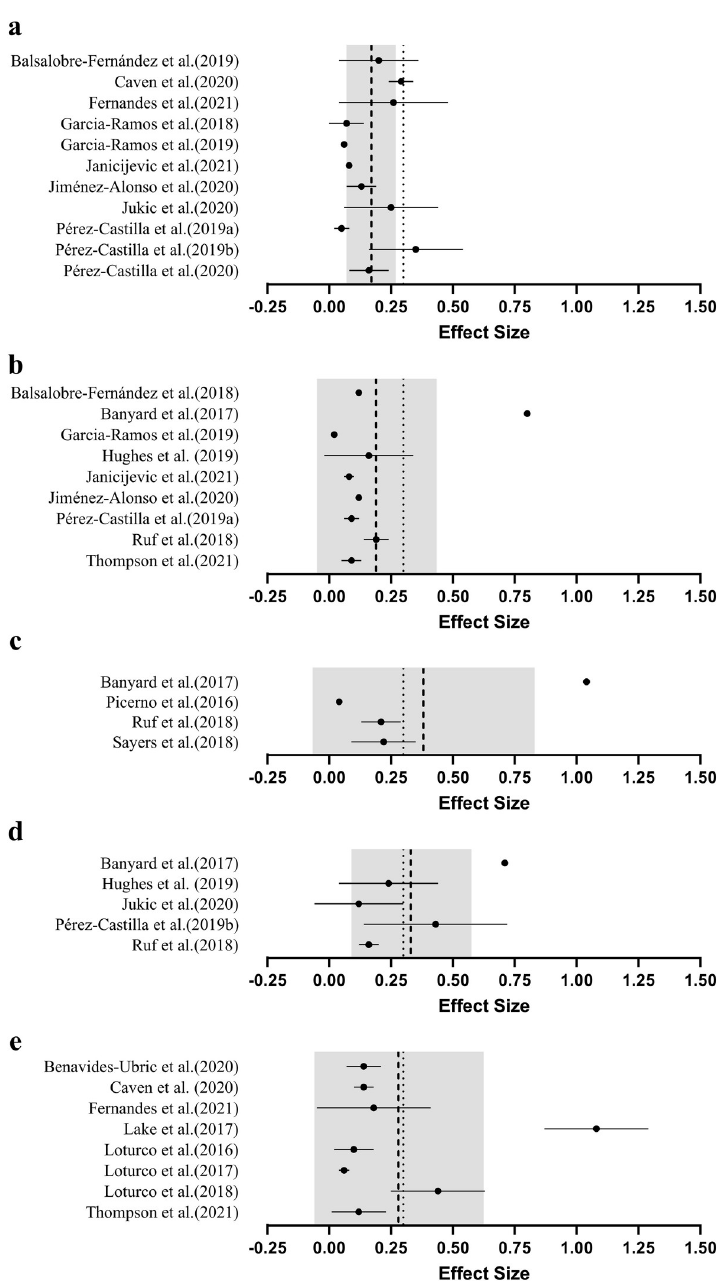
Fig 3. Mean ( ● ) effect sizes ( ± SD), grouped average (---) and recommended maximum effect size ( ��� ) for magnitude of difference between predicted and actual 1RM by the number of loads used for their prediction model; a.) 2-point method, b.) 3-point method, c.) 4-point method, d.) 5-point method, e.) � 6-point method. The grey band represents the standard deviation of the pooled effect sizes. Note : Effect sizes closer to zero indicate greater validity (i.e., smaller difference between actual and predicted